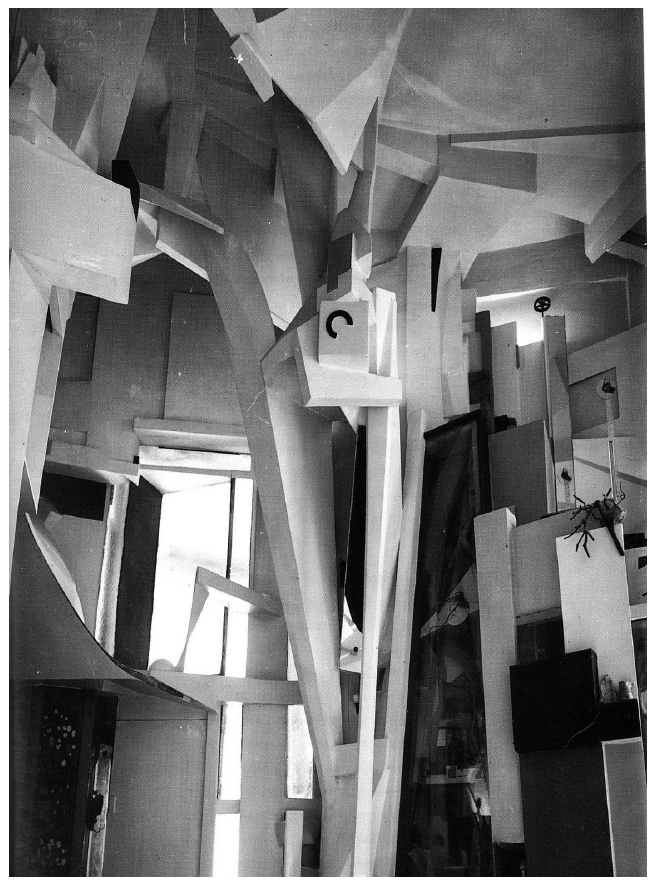
Fig. 12 Kurt Schwitters, Merzbau, Hannover, 1933 (Mindrup,